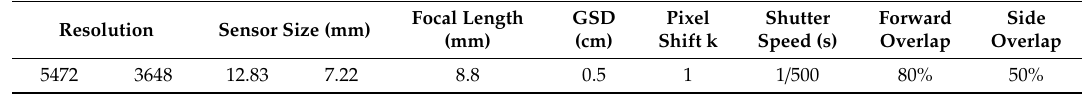
Table 3. Calculated parameters. Table 2. Predefined parameters. GSD—ground sample